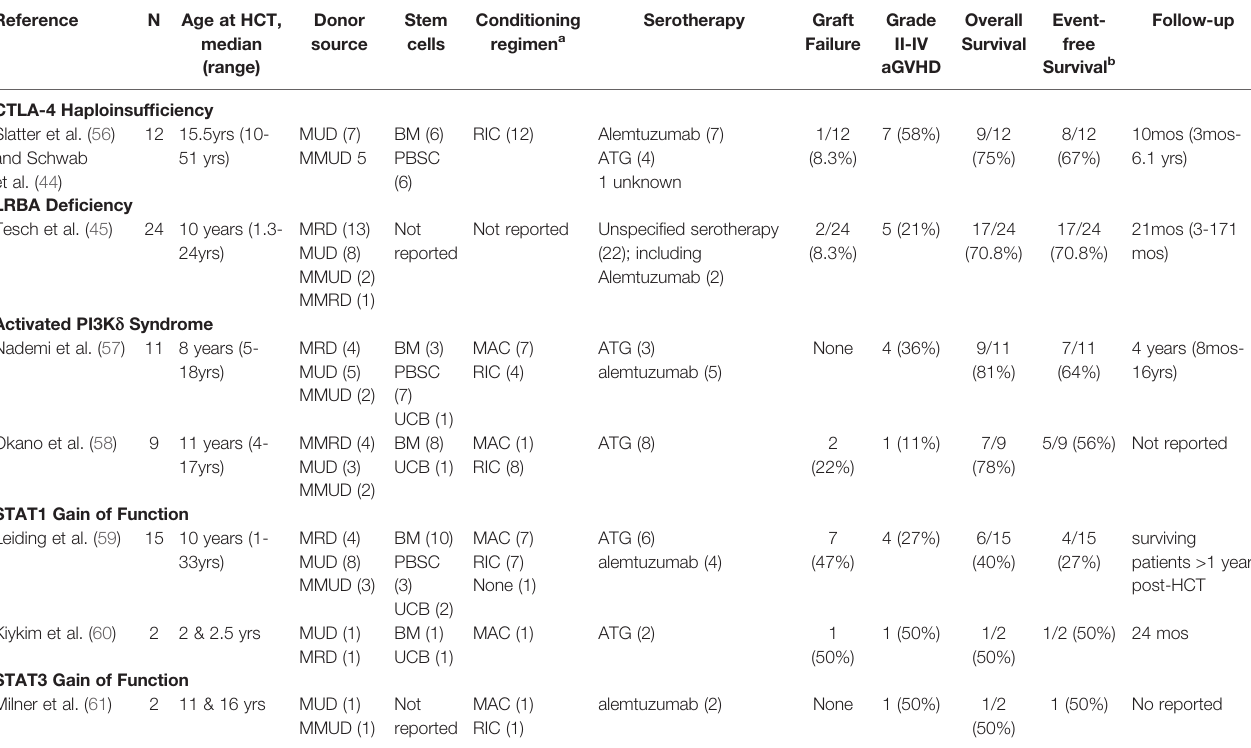
TABLE 2 | Hematopoietic cell transplantation outcomes for CTLA-4 haploinsuf fi ciency, LRBA de fi ciency, activated PI3Kd syndrome, and STAT1 and STAT3 Gain of Function. Reference